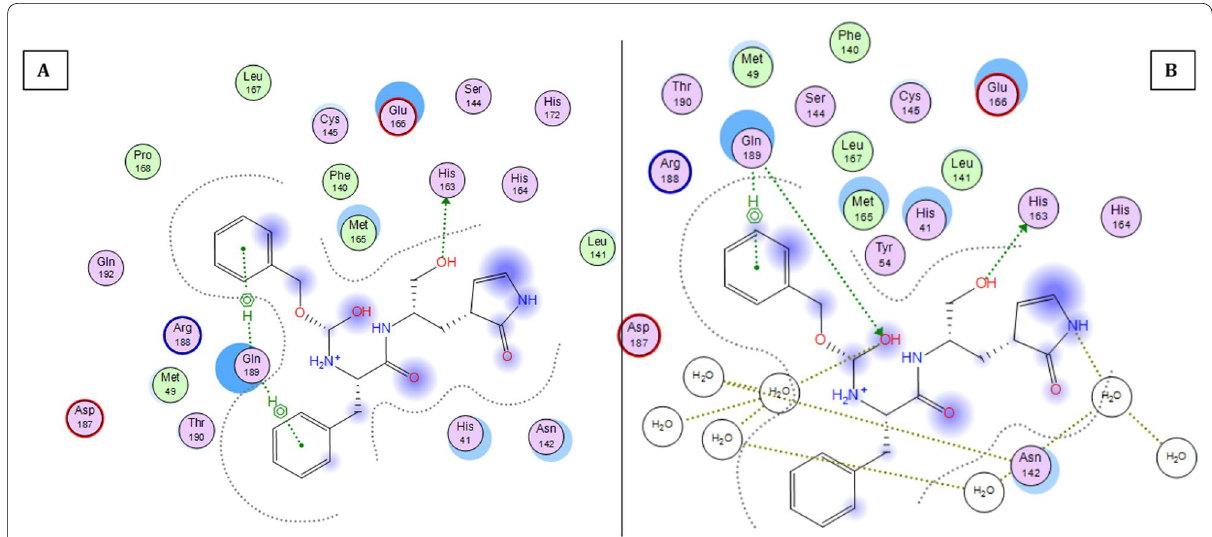
Fig. 11 2D interaction of REF-IN A Before Molecular dynamics study and B After Molecular dynamics analysis